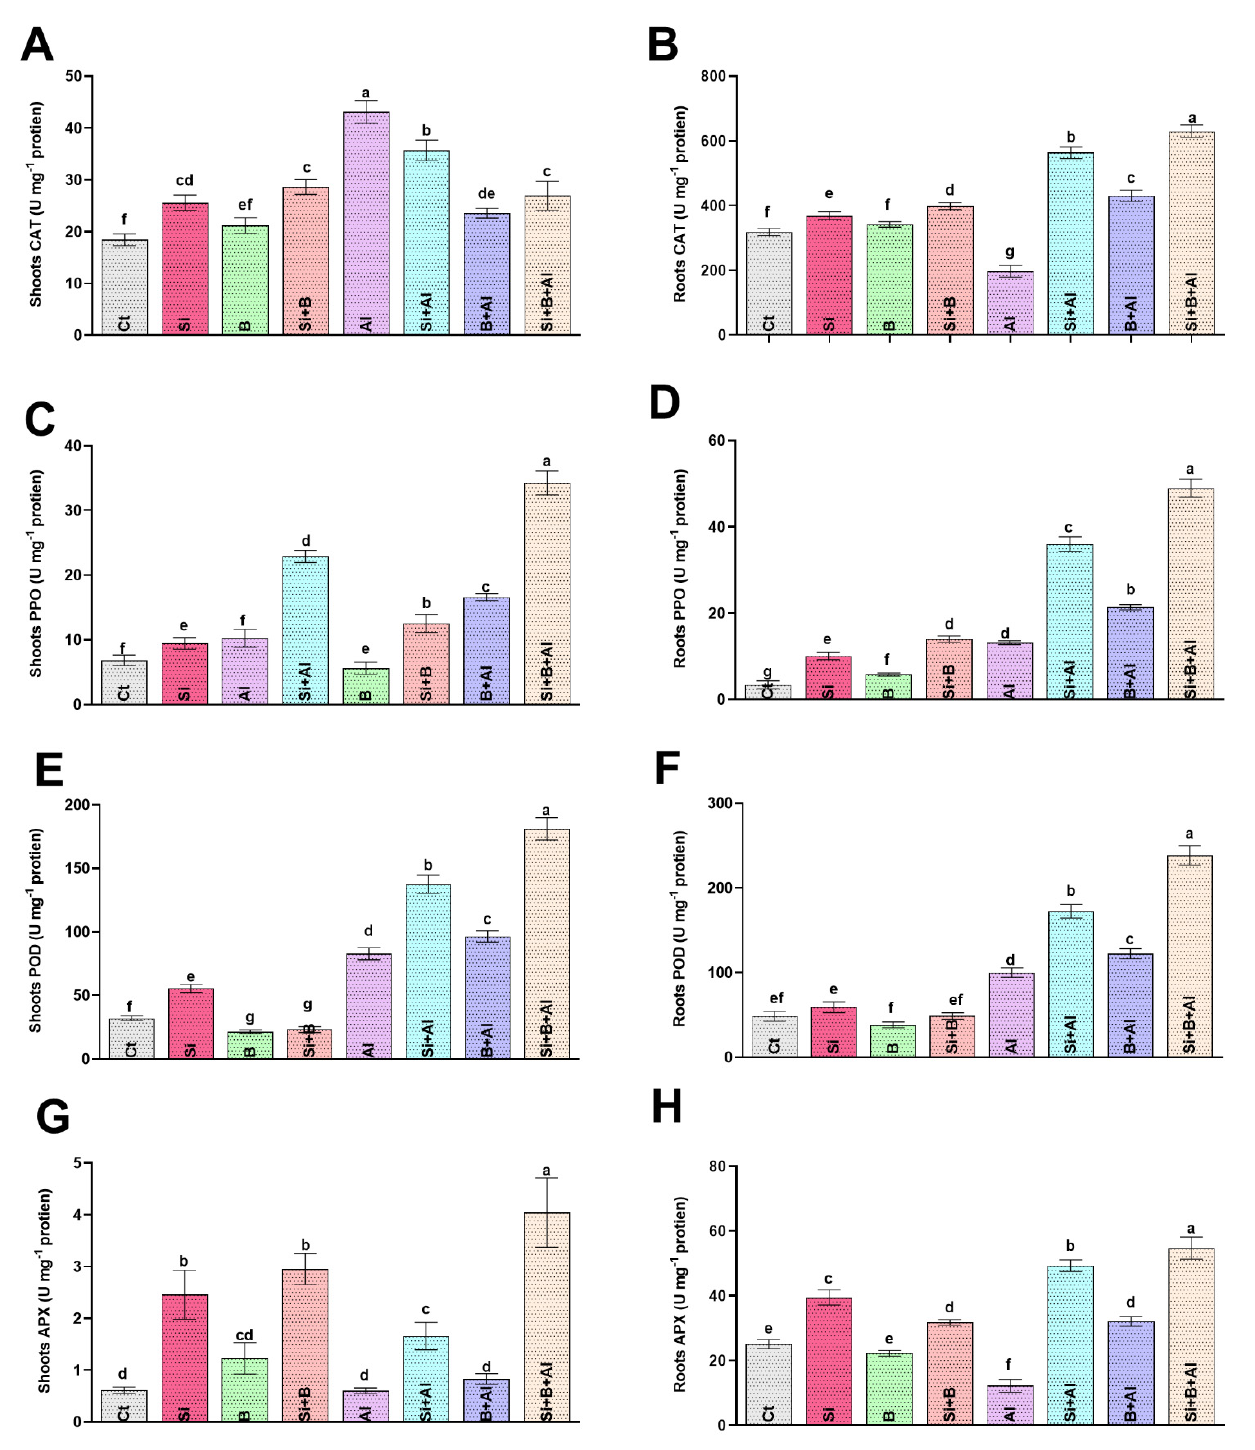
Figure 3. The effect of sole silicon (Si), boron (B), and their combination on antioxidant regulation (catalase, CAT; polyphenol oxidase; PPO peroxidase, POD; and ascorbate peroxidase, APX;) of date palm roots and shoots under Al-induced stress. ( A , B ) CAT, ( C , D ) PPO, ( E , F ) POD, ( G , H ) APX. Bars with different letters are describing statistically significant differences ( p < 0.05) between means by using one-way analysis of variance (ANOVA), followed by Duncan’s multiple range test (DMRT). Values describe the mean (of four replicates) ± the standard error.